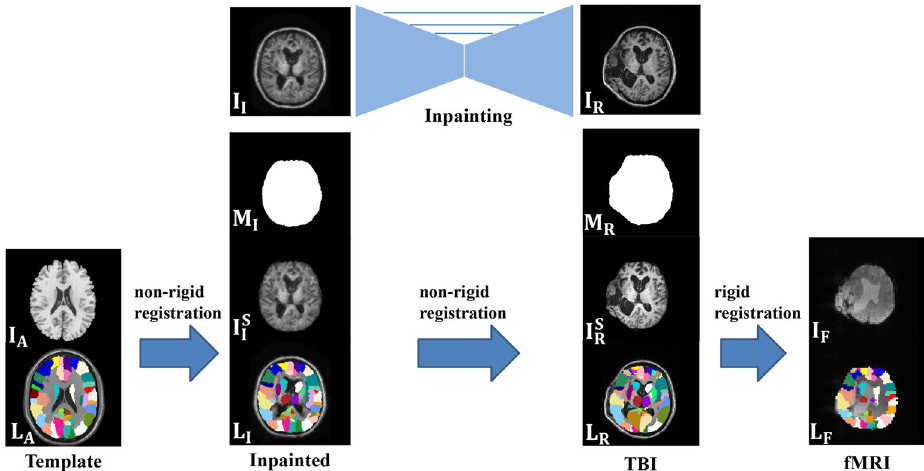
Fig. 2 Hydrocephalus brain parcellation framework with the aid of the abnormality inpainting method. The three major registration steps are designed to warp the label map from the atlas template (left) to the mean EPI of the fMRI image